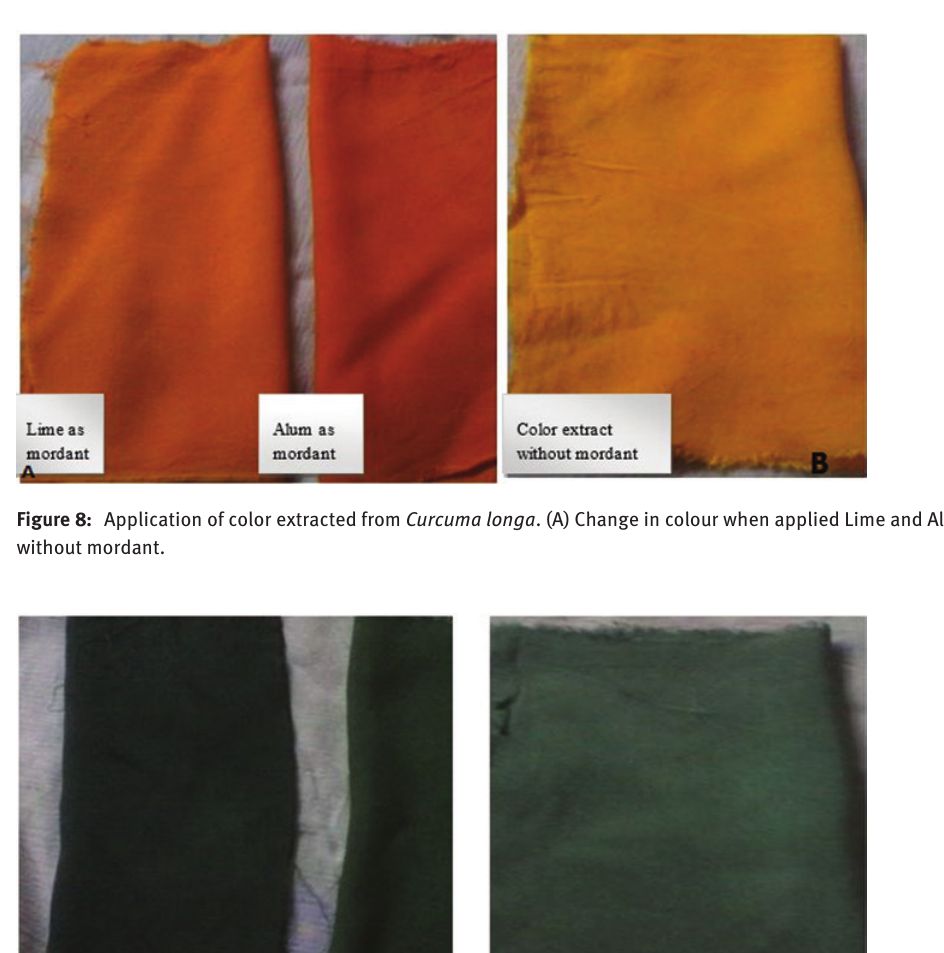
Figure 7: Application of color extracted from Citrus limon . (A) Change in colour when applied Lime and Alum as mordant (B) Colour effect without mordant.